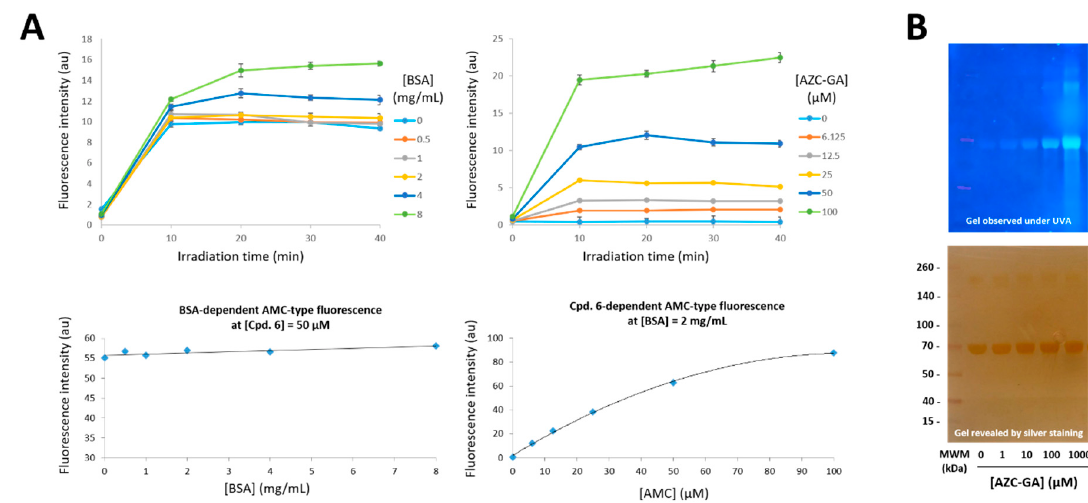
Figure 4. Fluorimetric and SDS-PAGE analysis of the fluorogenic photoalkylation of BSA by AZC-GA 5 . ( A ): 50 µ M AZC-GA 5 in RIPA lysis bu ff er were used for the dose–response photoalkylation of BSA (0 to 8 mg / mL) at various irradiation times (left top panel). 2 mg / mL BSA in RIPA lysis bu ff er were used for the dose–response photoalkylation by AZC-GA 5 (0 to 100 µ M) at various irradiation times (right top panel). Dose–response variation of AMC-type fluorescence was assessed using BSA (0 to 8 mg / mL, left bottom panel) and non-photoactivated 6 (0 to 100 µ M (right bottom panel), taking 6 as exemplary of the AMC fluorophore present in AMC-GA-BSA photoadducts (Figure 2). Fluorimetric analysis was performed on a Xenius XML spectrofluorimeter (SAFAS, Monaco) at 23 ◦ C using the following detection settings: λ EX = 360 nm, λ EM = 448 nm. Values represent the mean of three sequential measurements (interval time = 5 s). Standard deviations are systematically shown on the plots but are often invisible due to their close-to-zero values. ( B ): 2 mg / mL BSA in RIPA lysis bu ff er was used for the dose–response photoalkylation by AZC-GA 5 under UVA irradiation for 20 min. Noteworthy, BSA shows slight blue autofluorescence in the absence of AZC-GA 5 (lane 0 µ M). Fluorescence revelation was performed using the UV bed of an E-Box VX2 scanner (Vilber-Lourmat, Collegien, France) and pictured as seen with the naked eye. All photoactivations were performed on ice (0–4 ◦ C). MWM = molecular weight